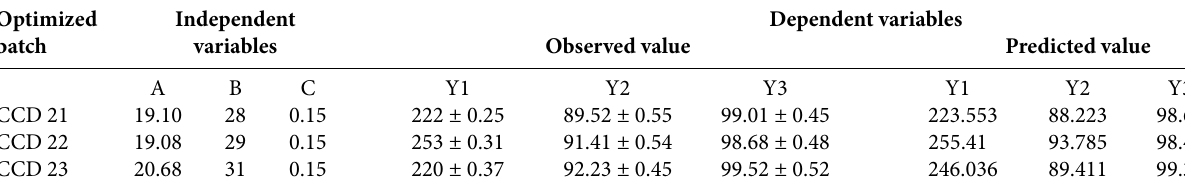
Table 10. Results of optimized batches obtained from an overlay plot of design expert software. Optimized batch